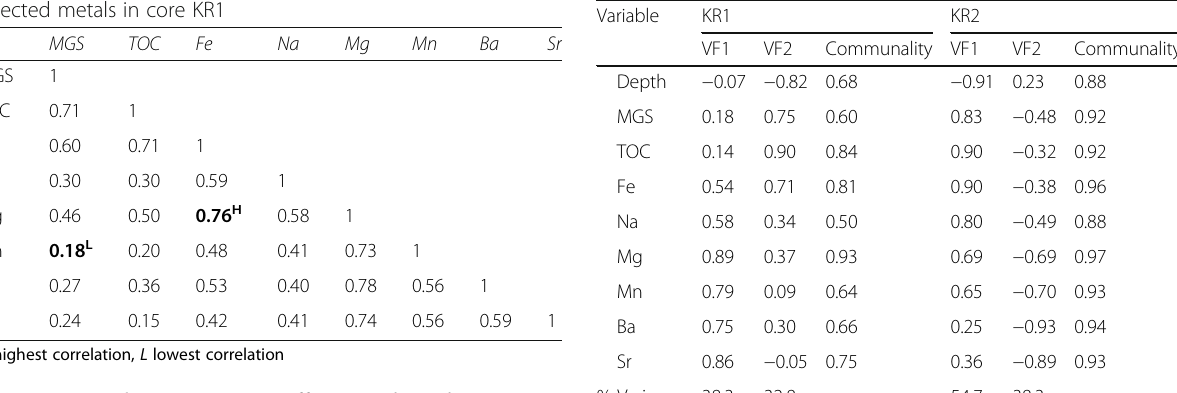
Table 4 Varifactors of varimax rotated loading